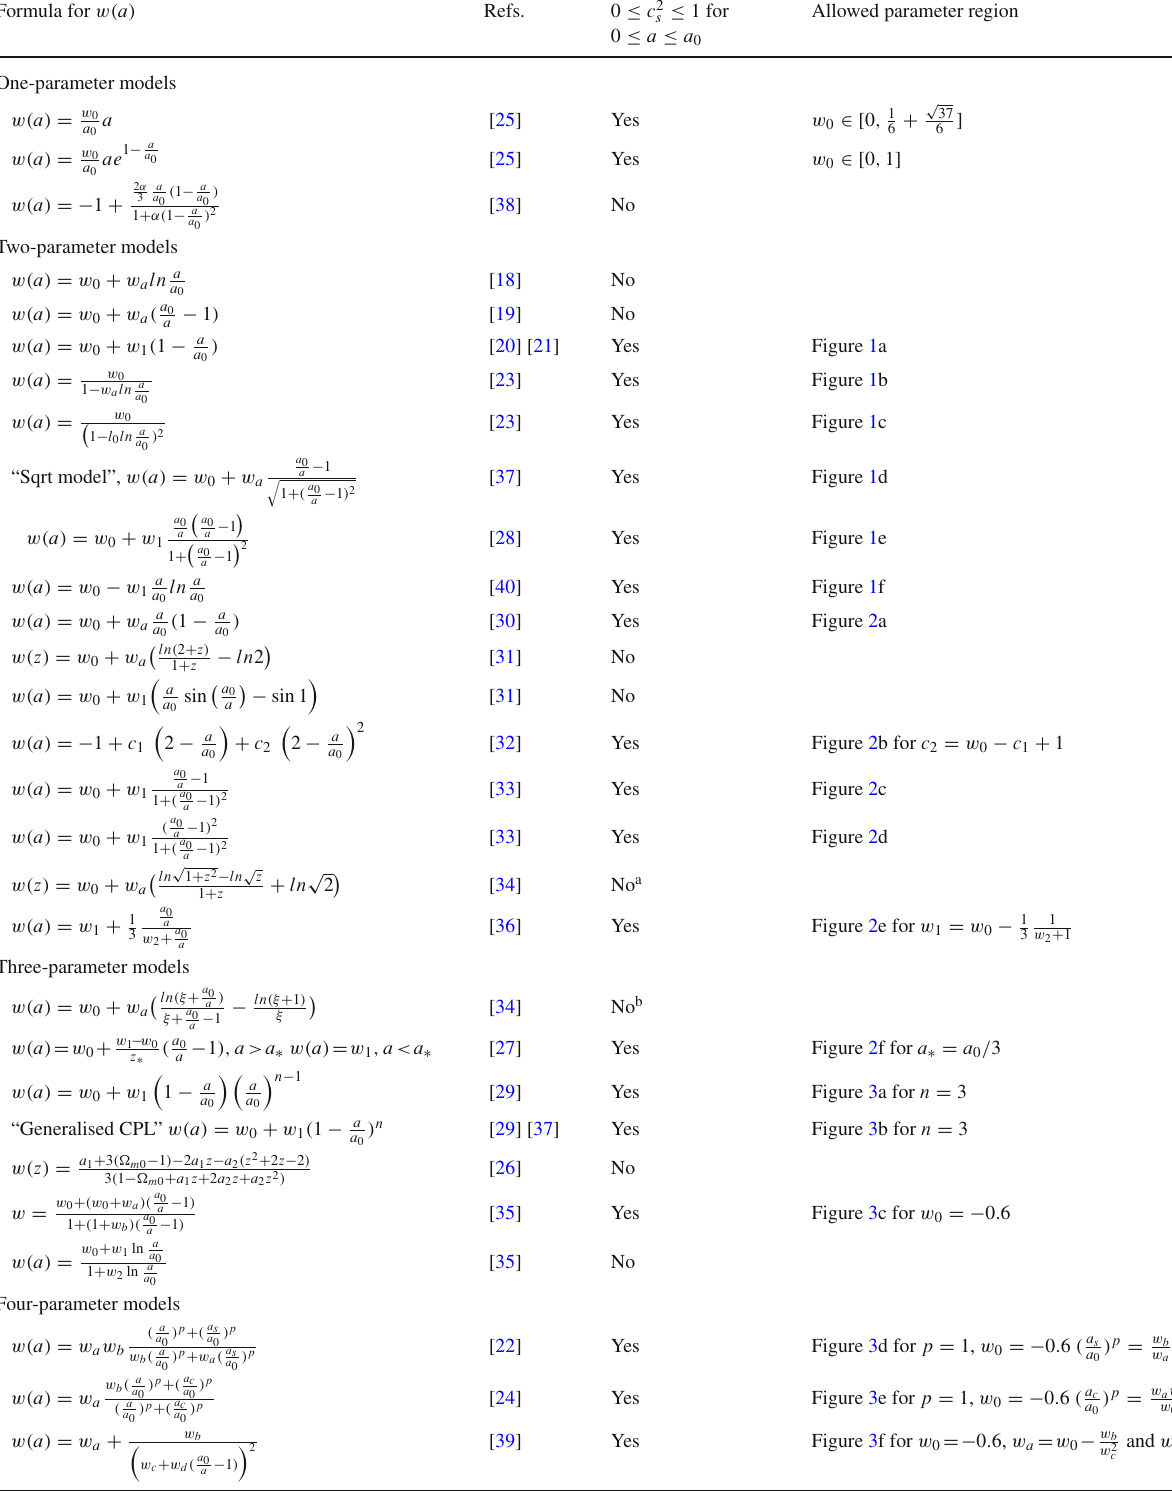
Table 1 Overview of studied models, their w( a ) (or w( z ) ) parametrizations and allowed regions of parameters Formula for w( a ) Refs.